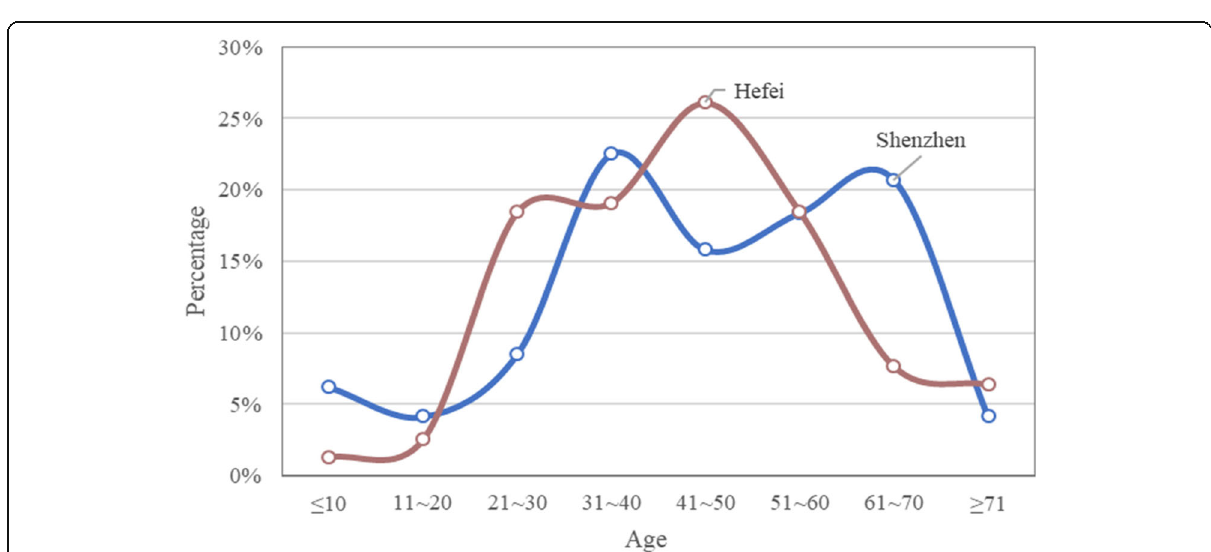
Fig. 3 Association between age and the number of infected